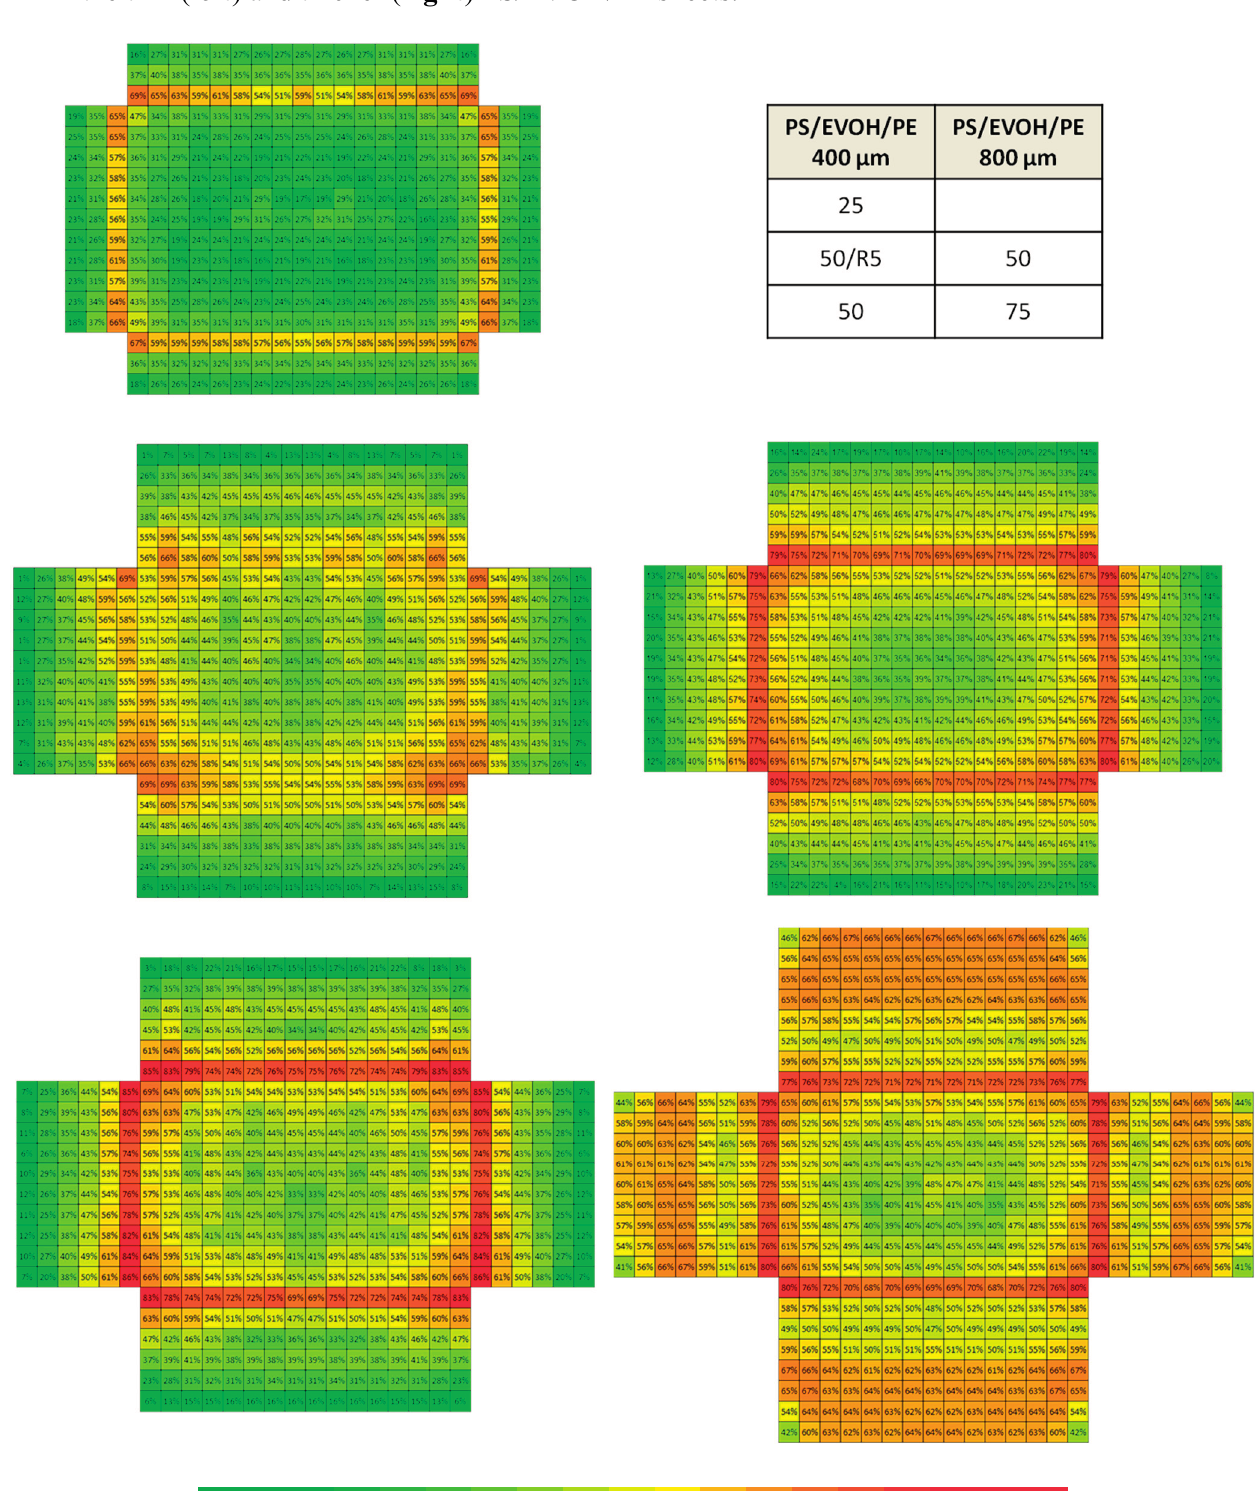
Figure 5. Visual representation of percentage thinning in 25-, 50/R5-, 50-, and 75-trays of the thin ( left ) and thicker ( right ) PS/EVOH/PE